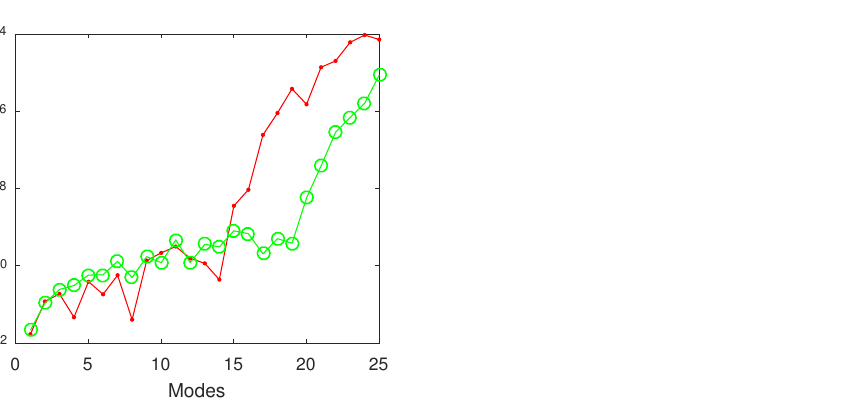
Figure 11. The absolute drift with respect to N of the first 25 eigenvalues for the Schrödinger problems (1)–(6) with Coulomb-type decay potential (9), computed by mapped ChC with scaling factor c : = 2; red dotted line for the case N 1 : = 512 and N 2 : = 1024 and green circled line for the case N 1 : = 760 and N 2 : =